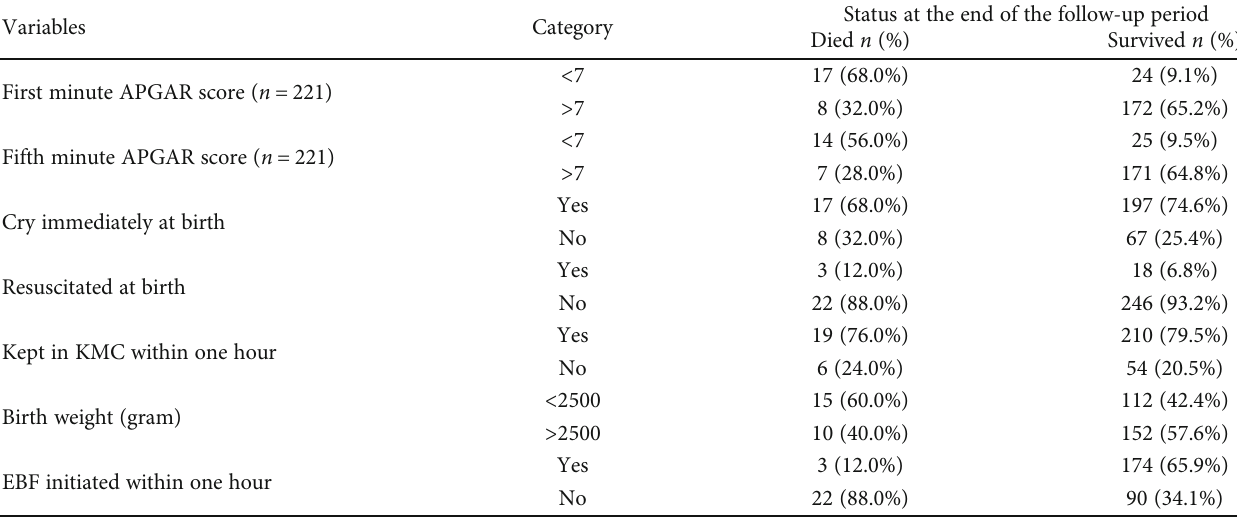
Table 3: Neonatal characteristics of newborn admitted with neonatal sepsis at public hospitals in Ethiopia. Variables